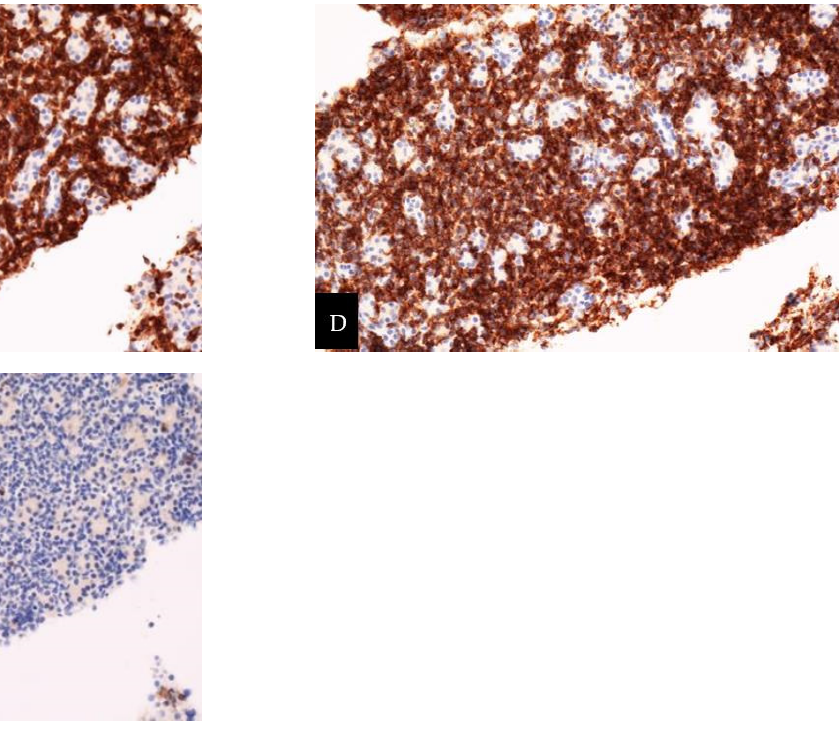
Figure 4. Pathologic findings. ( A ) Acinar cell structure is destroyed by diffusely infiltrated tumor cell (HE, ×100). ( B ) Irregular pleomorphic hyper-chromatin nuclei is observed (HE, ×400). ( C , D ) CD 3 and CD 56 is positive in immunohistochemical (IHC) stain. ( E ) CD 20 is negative in IHC stain.